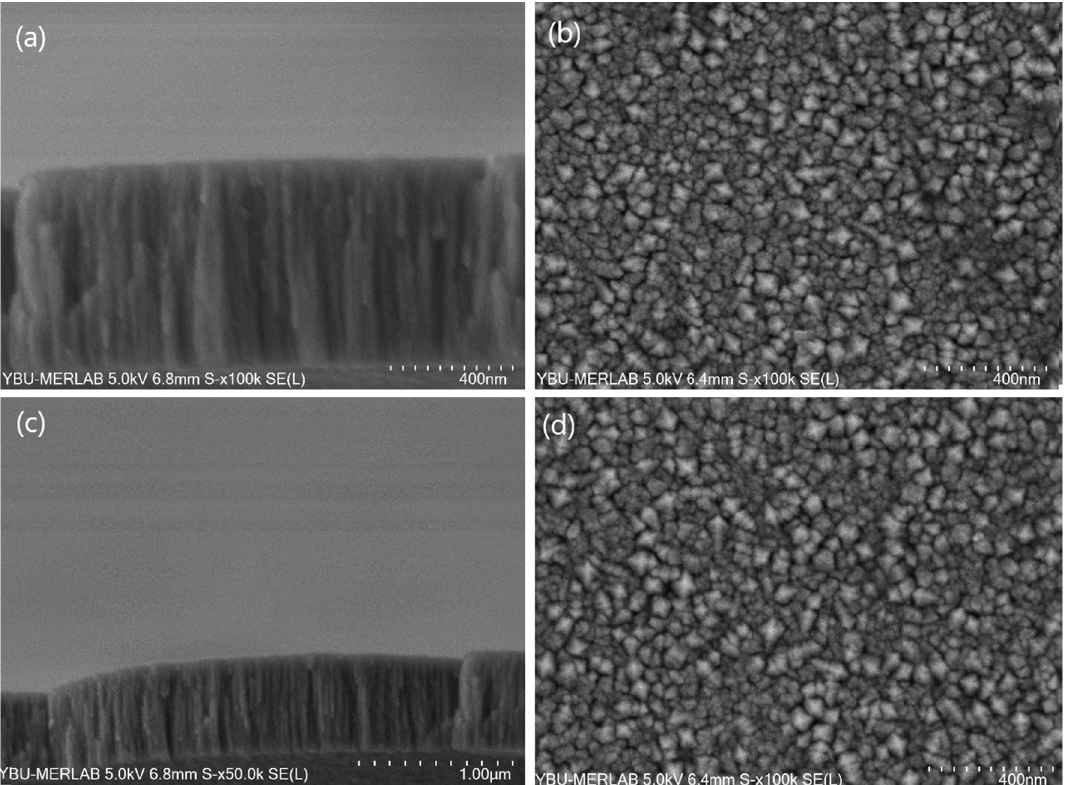
Figure 2. The scanning electron microscopy images of the prepared thin-film catalysts. For the NiCr coating catalyst: ( a ) cross-section SEM images and ( b ) close-up planar SEM images. For the NiV coating catalyst: ( c ) cross-section SEM images and ( d ) close-up planar SEM images.